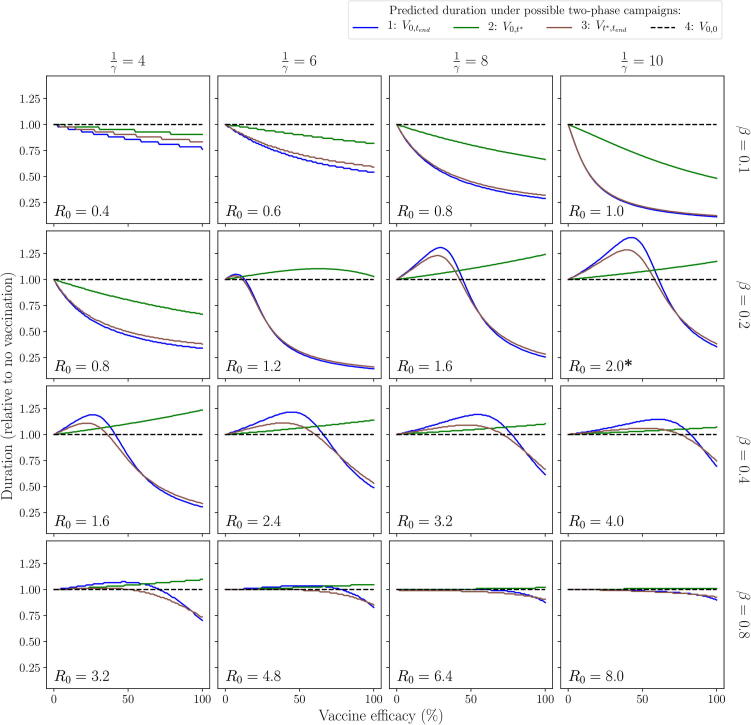
Effect of epidemiological transmission and recovery rates on campaign performance - Scenario 2. All other parameters are fixed to the values given in Table A.2. The asterisk identifies the default combination of transmission and recovery rates used in scenario 2.